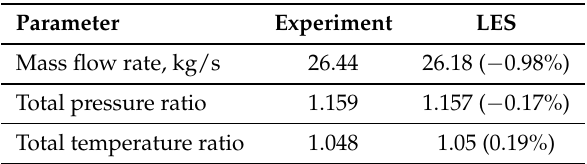
Table 2. Performance comparison between the experiment and the computation. The relative difference with the experimental data is shown in brackets for each case.